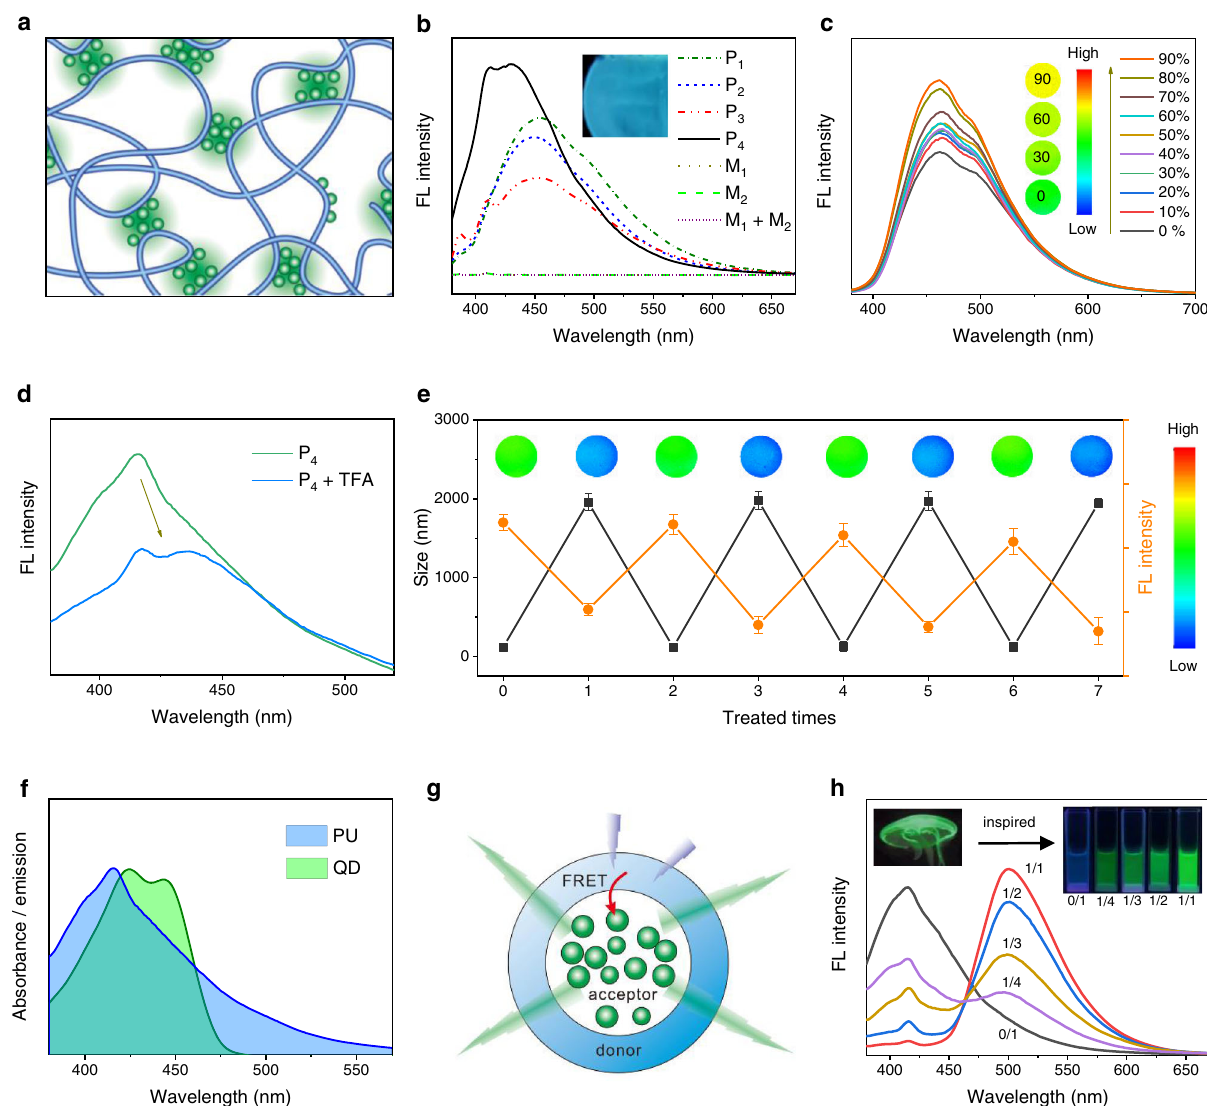
Fig. 3 | Nonconventional fl uorescence properties.a Schematicillustration of the fl uorescent chromophore of PUs. The green spherical clusters indicate the collec- tion of carbonyl moieties. b Fluorescence spectra of PU assembles and monomers (1mgmL − 1 ). M 1 , M 2 , and M 1 +M 2 represent Cys·OMe, L-Lys·OEt, and their mixture (molarratio1:1).TheinsetshowsaphotographofPU fi lmundera365nmUVlamp. c FluorescencespectraofPUinDMF/CHCl 3 mixtureswithCHCl 3 fractionsfrom0to 90%. Insets show the emission images of PU in the mixtures with different CHCl 3 fractions (0, 30, 60, and 90%). d fl uorescence spectra of P 4 assemblies before and after addition with 16% TFA. e Particle sizes and fl uorescence intensity of PU